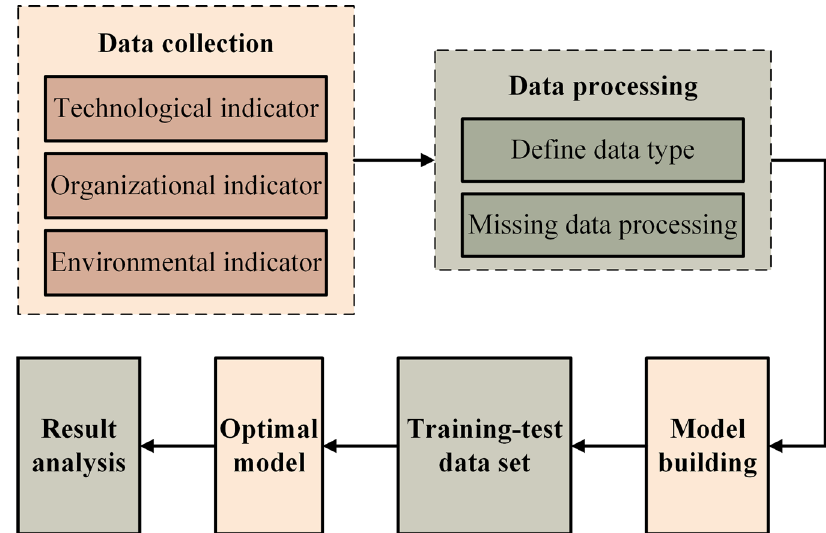
Fig. 2 Technology roadmap. This paper analyzes through the steps of data collection, data processing, model building, selection of optimal model and result analysis.